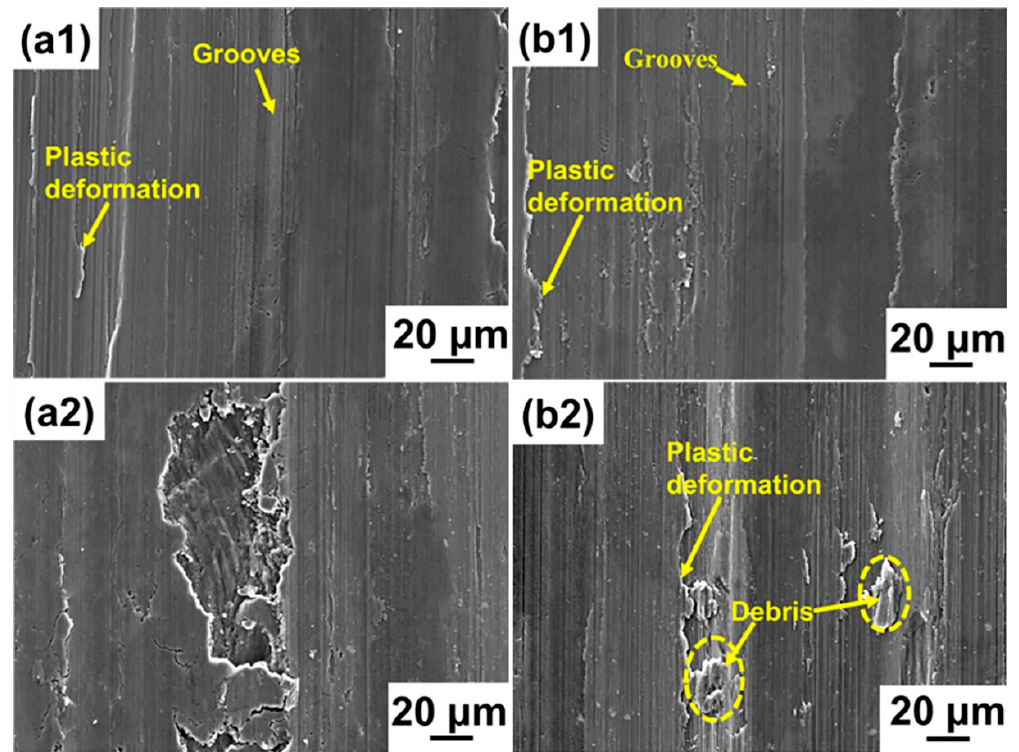
Figure 6. SEM morphologies of the worn surfaces in SE mode: ( a1 ) The as-SLM alloy; ( b1 ) SLM-T6 alloy; ( a2 ) AA2024-O alloy; ( b2 ) AA2024-T6 alloy.